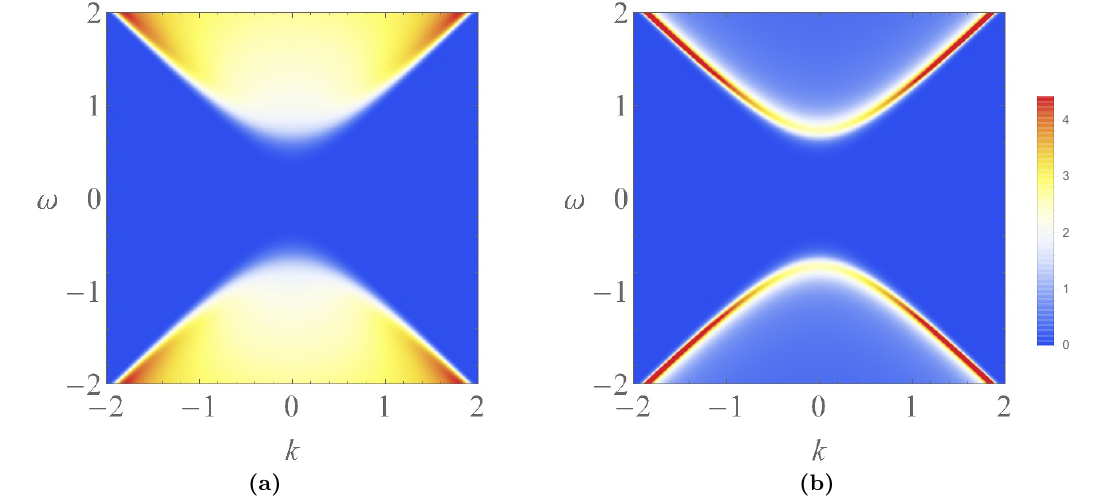
Figure 1 . (a) The holographic spectral function. (b) The holographic spectral function in alter- native quantization. In both (a) and (b), (cid:21) = 1. The legend on the right holds for both (cid:12)gures. Here, and in all the following plots, all quantities are made (scale) dimensionless by dividing by the appropriate power of M 0 , and we choose q = 1, M = 1 = 4, T = 1 = 100 unless stated